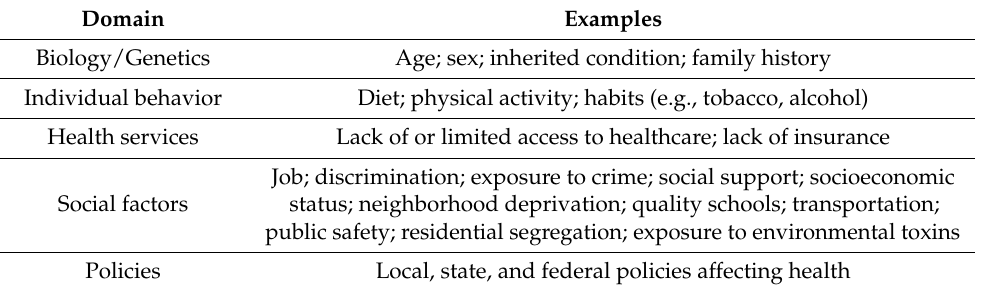
Table 1. Domains of determinants of health with examples. Adapted from Healthy People 2020 [11]. Domain